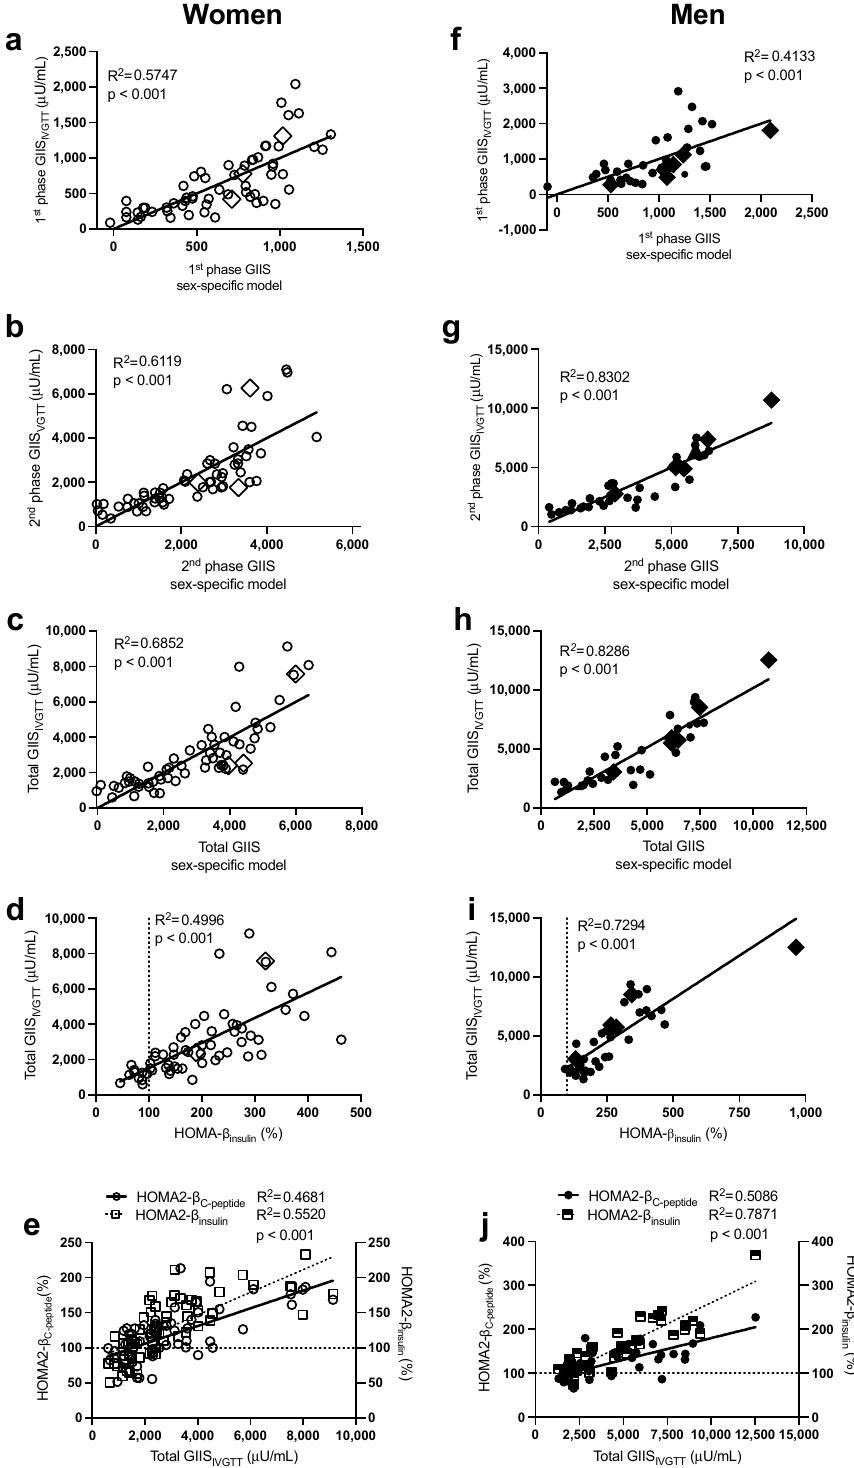
Figure 1. Pearson correlations between the sex-specific models, with their corresponding data for first-phase GIIS IVGTT in women ( a ) and men ( f ), second-phase GIIS IVGTT in women ( b ) and men ( g ), and total GIIS IVGTT in women ( c ) and men ( h ), between HOMA- β insulin with total GIIS IVGTT in women ( d ) and men ( i ), and between total GIIS IVGTT with HOMA2- β insulin and HOMA2- β C-peptide in women ( e ) and men ( j ). Women are in open circles (N = 61, those with BMI > 40 kg/m 2 are in open diamonds) and men are in closed circles (N = 37, those with BMI > 40 kg/m 2 are in closed